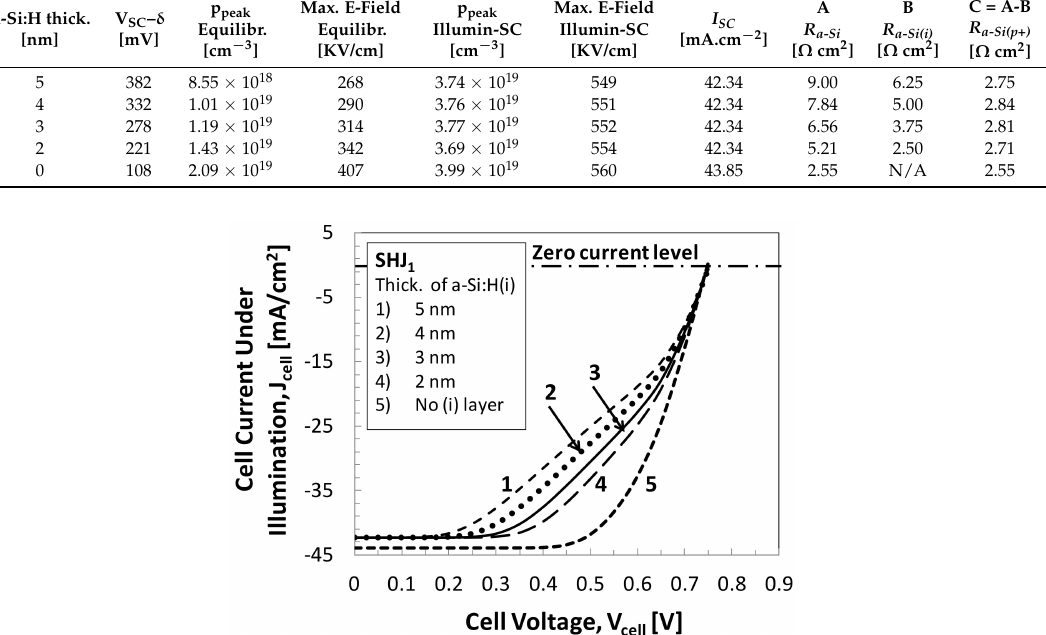
Figure 9. Simulated I-V characteristics under illumination for cell SHJ 1 with thermionic emission hole transport for different values of a-Si:H(i) layer